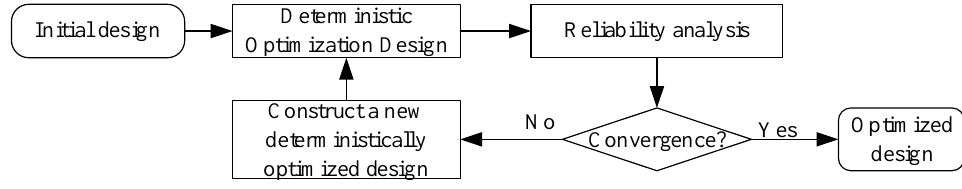
Figure 3. Flow chart of the SORA method.